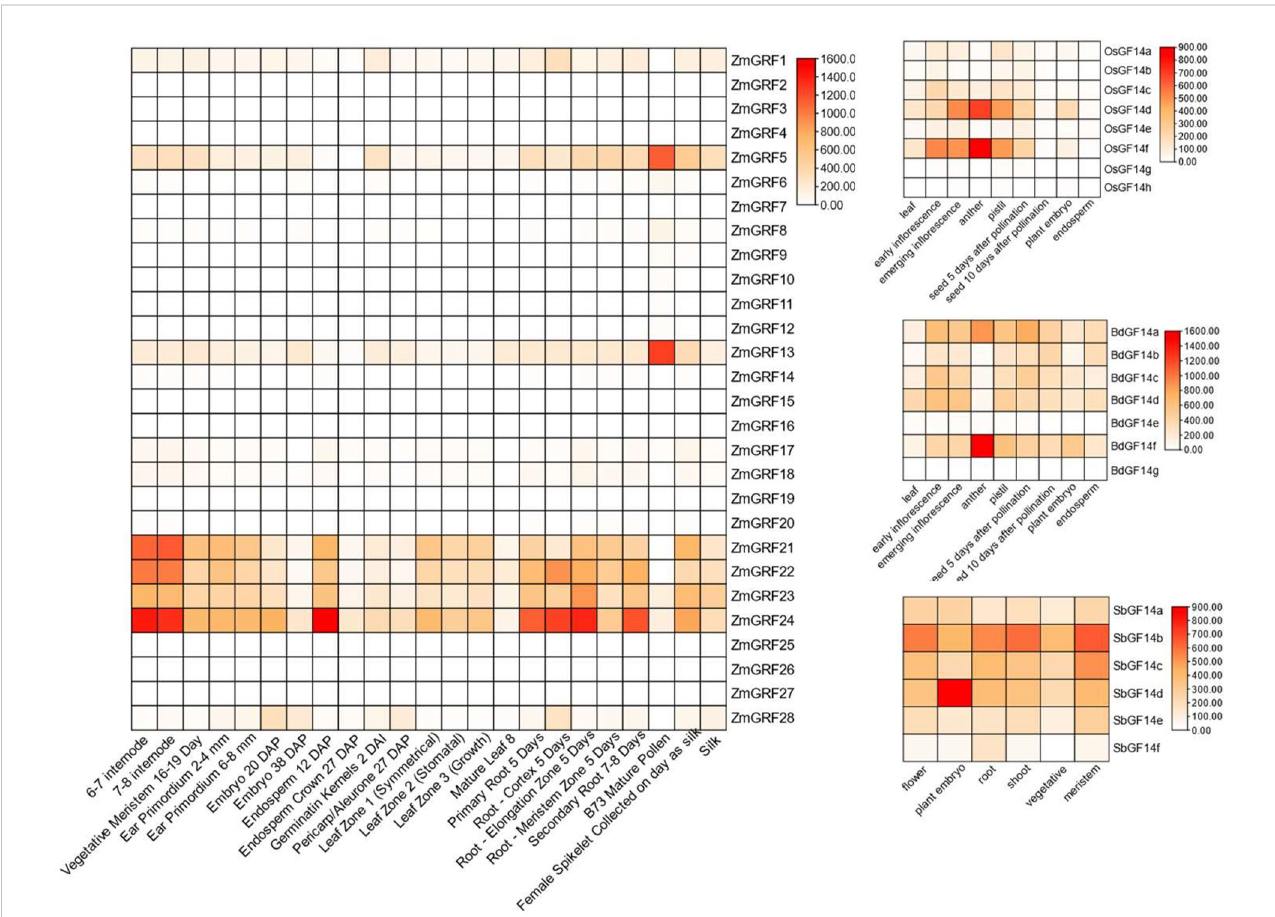
FIGURE 5 Heat maps of maize, sorghum, brachypodium, and rice 14-3-3 genes. Color scale at the right represents log 2 -transformed foldchange values. Red indicates high expression level; yellow indicates medium expression level; and white indicates low expression